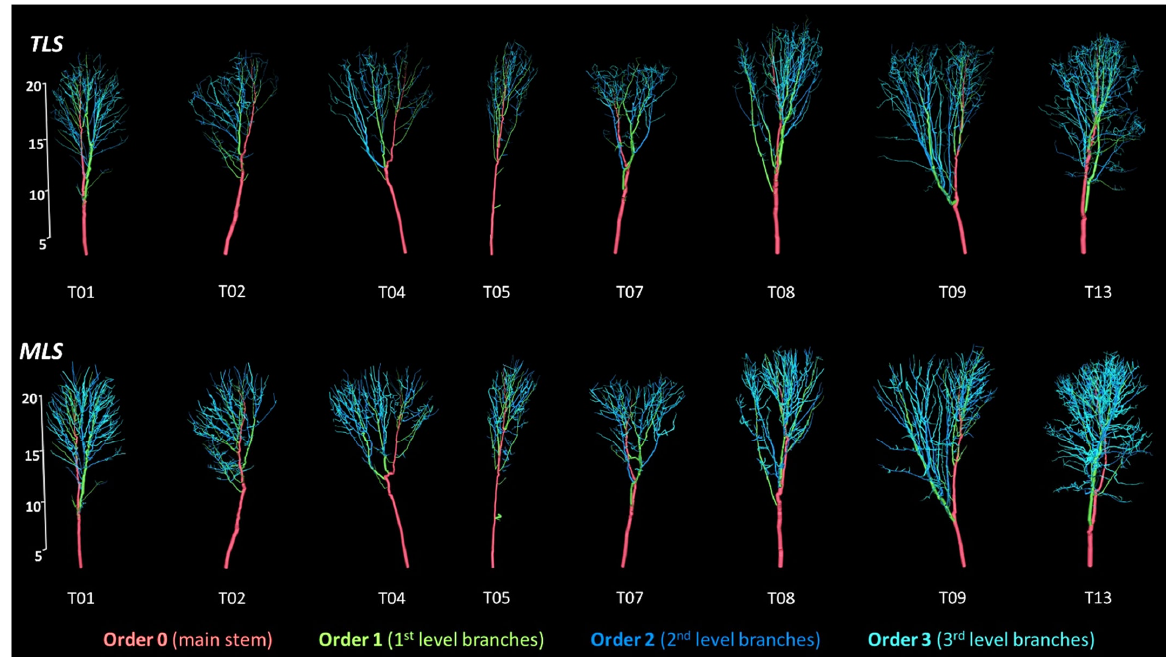
Figure 6. Examples of the quantitative structural models (QSMs) of hardwood trees reconstructed from TLS ( top ) and MLS ( bottom ) point clouds. Colors represent branching orders: red (order 0—main stem), green (1st ‐ order branches), blue (2nd ‐ order branches), cyan (3rd ‐ order branches).